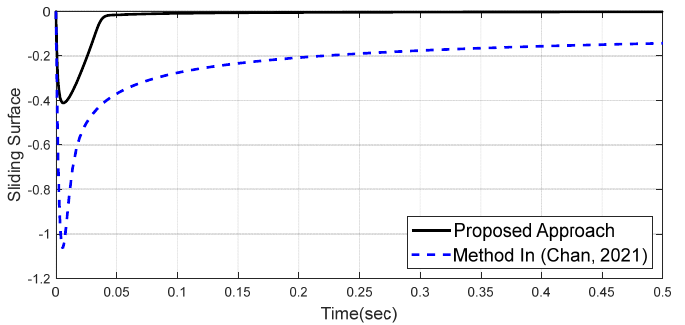
Figure 5. Sliding surfaces [1] .